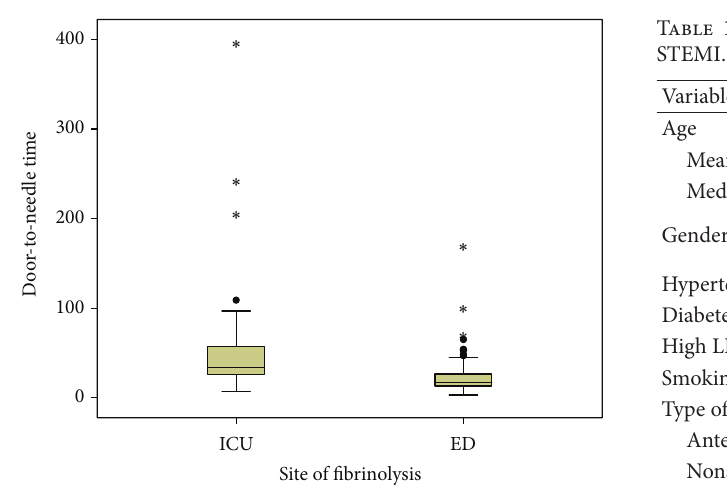
Figure 3: Box plot graph comparing DNT in both the ED and the CCU patient groups. CCU: coronary care unit and ED: emergency department.